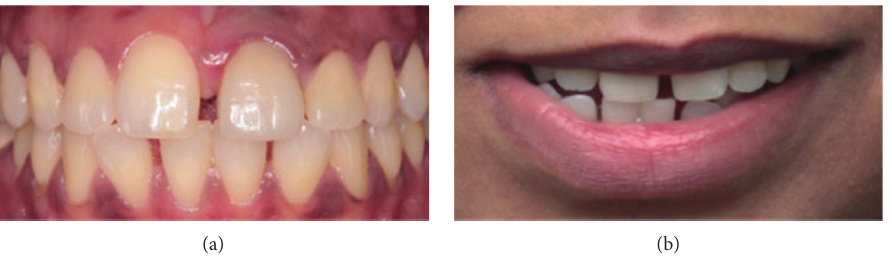
Figure 5: Moderate spacing.